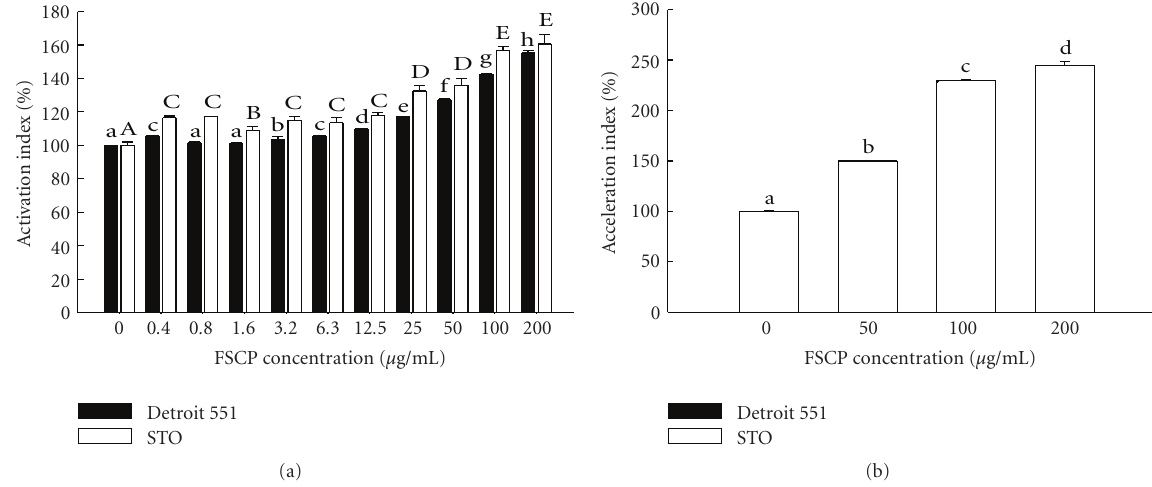
Figure 2: Cell proliferation and collagen release in embryonic skin fibroblast cell lines treated by FSCPs. Comparisons of the proliferation activity (a) and procollagen synthesis ability (b) on Detroit 551 cells (human embryonic skin fibroblast line) and STO cells (mouse embryonic fibroblast) treated with 0, 0.4, 0.8, 1.6, 3.2, 6.3, 12.5, 25, 50, 100, and 200 mM FSCPs. The group with no FSCPs acts as a control. After 48 hours posttreatment, the samples were analyzed by MTT and procollagen type I C-peptide ELISA assays. Bars stand as means ± standard deviation (triplicate for each